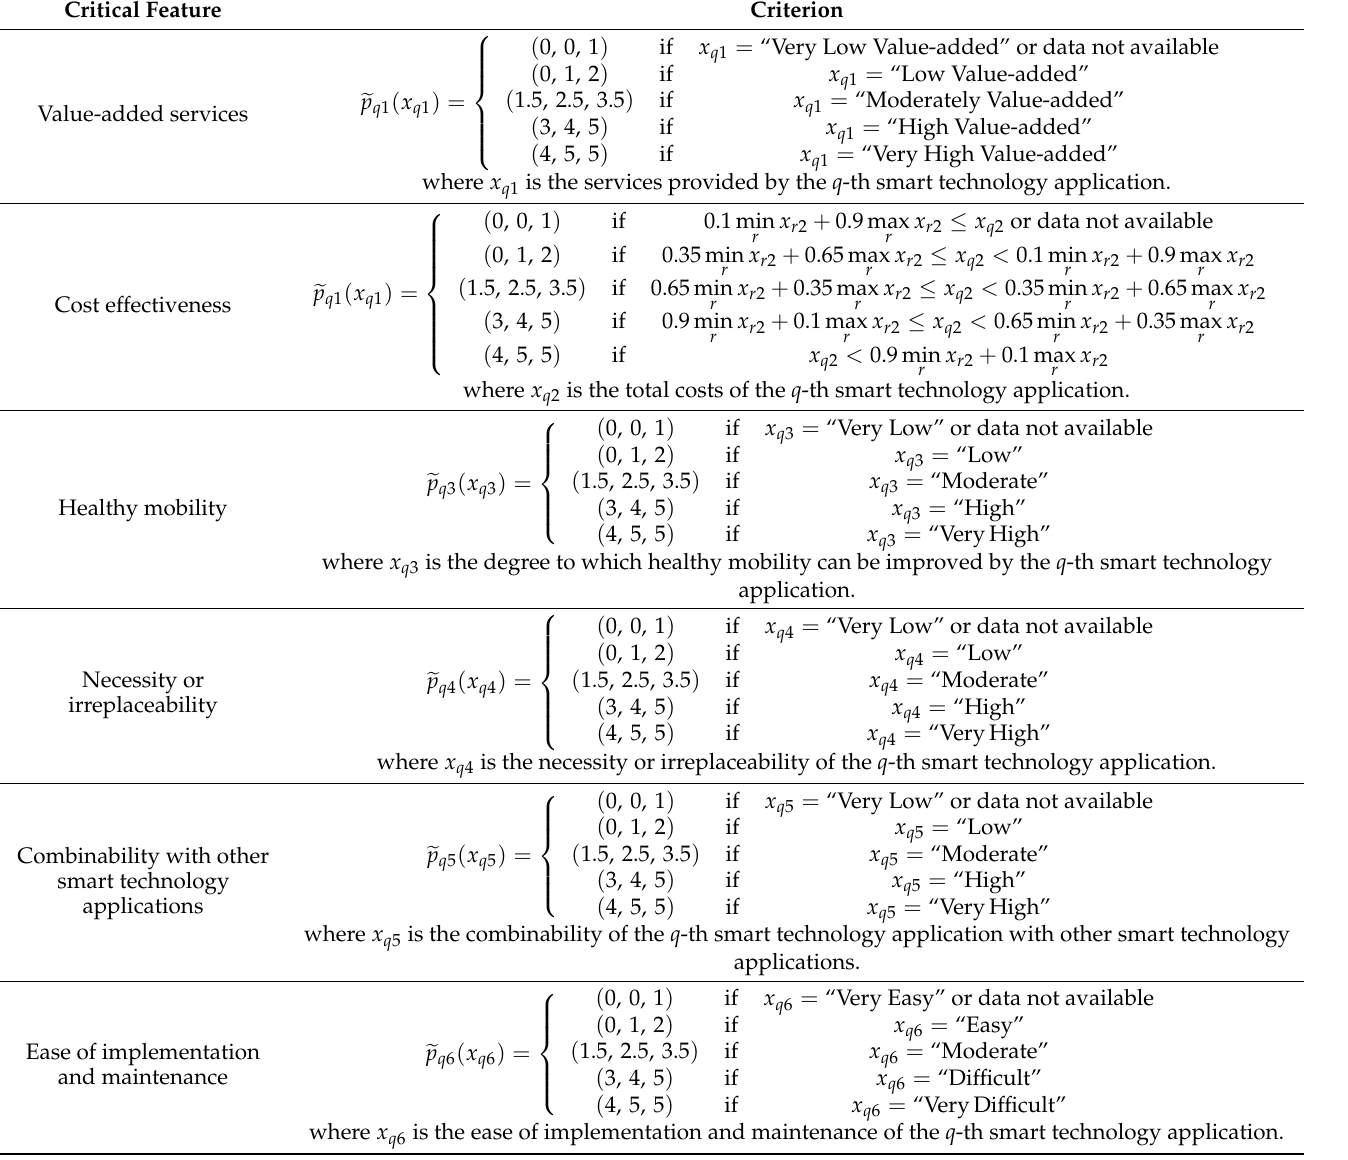
Table 5. Criteria for evaluating the performance of a smart technology application.